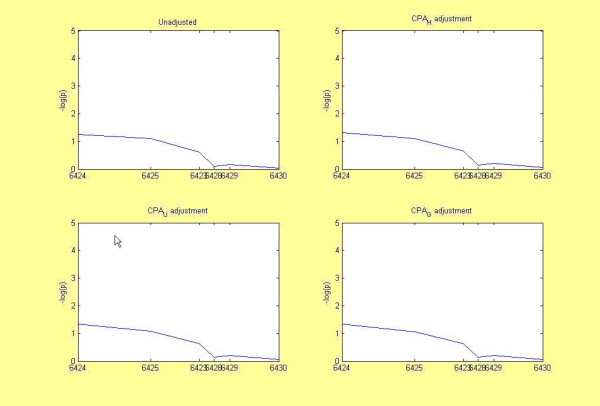
The transformed p-values of multiplicative SWEPT statistic based on different CPAs by using peak intensity data in Example 3.